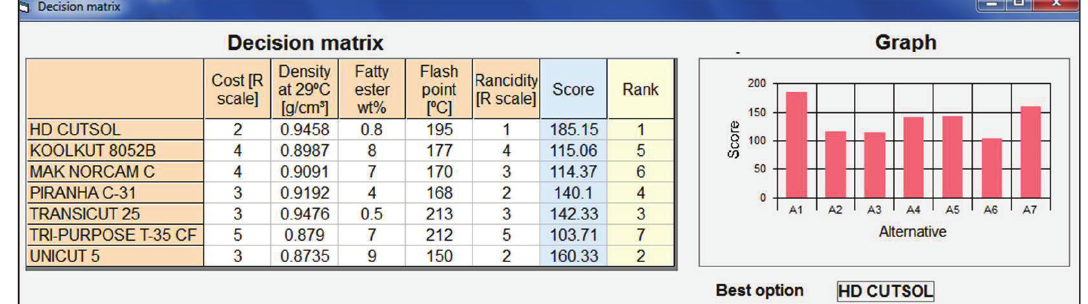
Figure 5: Decision matrix for Example